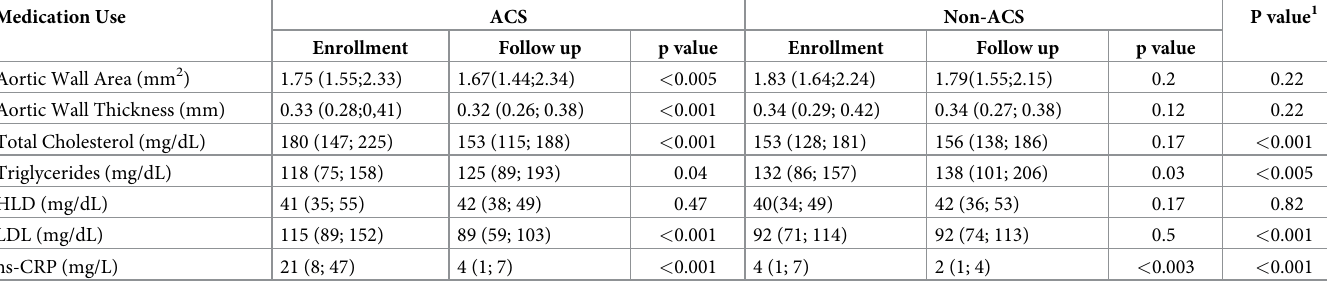
Table 2. Aortic wall thickness and serum markers at enrollment versus at three-month